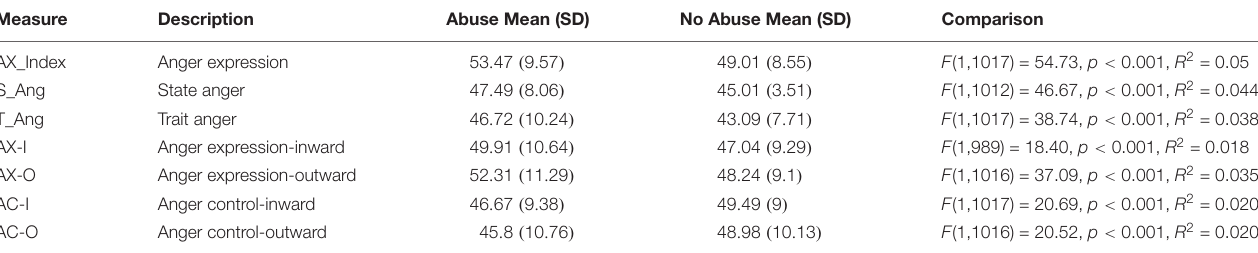
TABLE 2 | Sample means (standard deviations) for STAXI measures and group